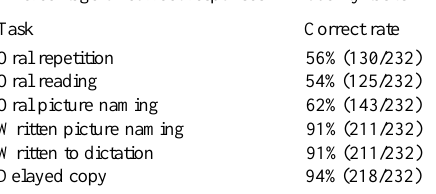
Percentage of correct responses in modality tasks